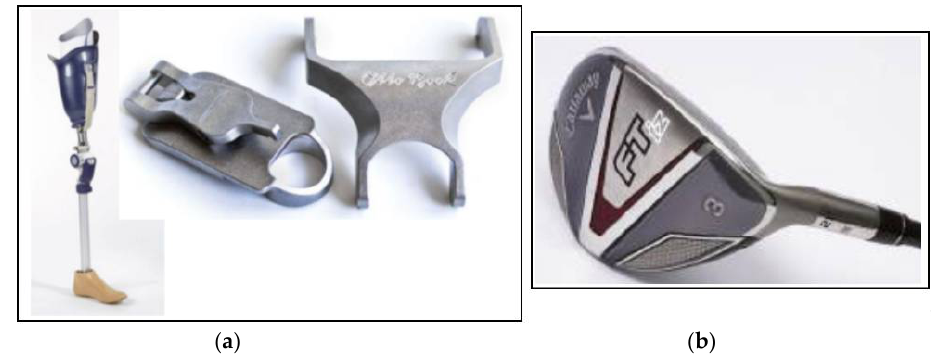
Figure 1. Sports application of the PIM process, ( a ) GKN Sinter Metals Germany produced MIM parts for the Otto Bocks prosthetic knee joint. ( b ) Callaway’s FT-iZ Hybrid golf club uses adjustable weights produced by MIM (Images PIM International Vol. 4 No. 3,